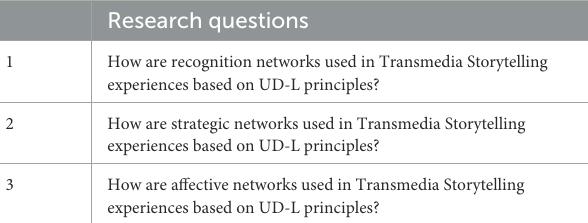
TABLE 1 Research questions of the study. Research